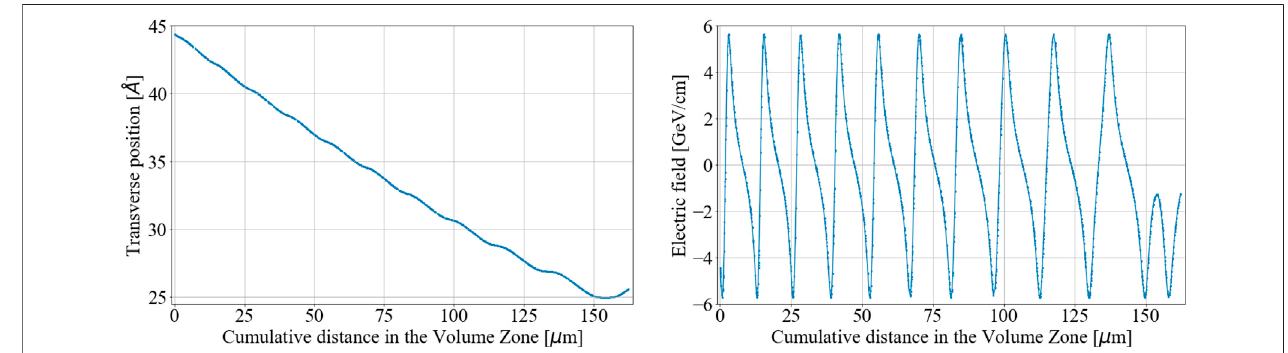
FIGURE 3 | Left: Quasi-channeled particle trajectory through a crystal close to the tangency point as a function of the cumulative longitudinal coordinate. Oscillations are due to the Molière potential and volume re fl ection can be seen at the right-hand side of the chart. Right: Corresponding electric fi eld along the particle trajectory.